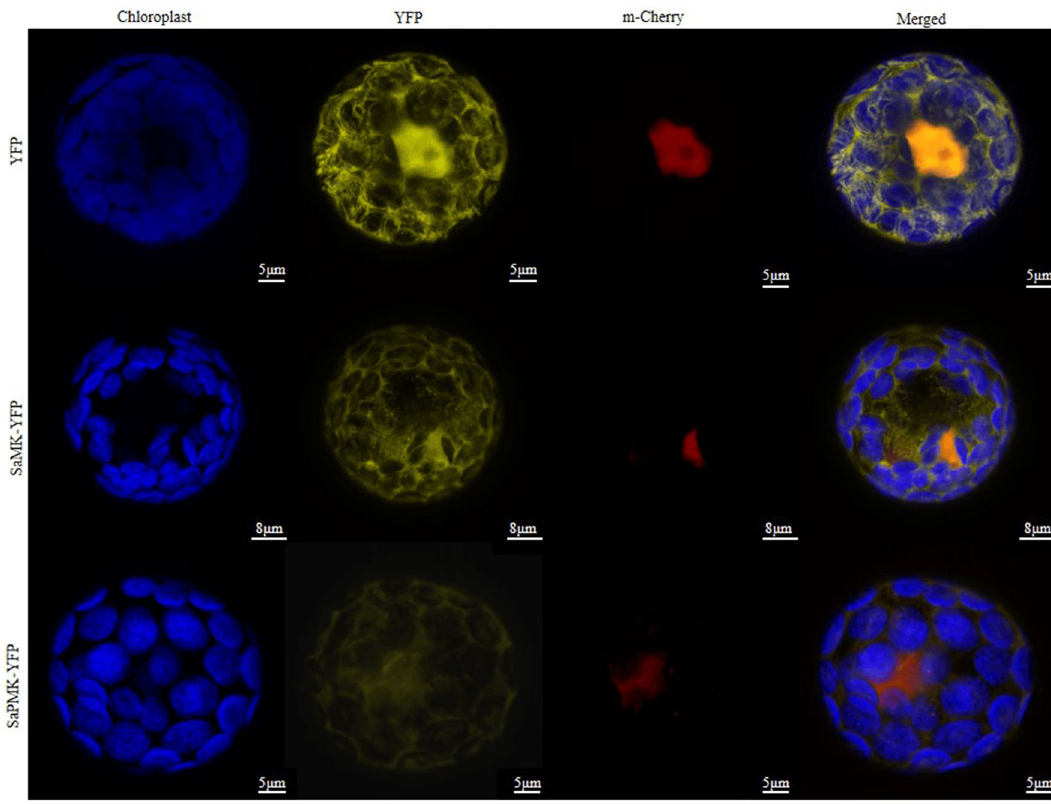
Figure 5. Subcellular localization of Santalum album SaMK and SaPMK. Blue fluorescence indicates chlorophyll (Chl) autofluorescence, yellow fluorescence indicates YFP and fusion vectors signal, and red signal indicates m-Cherry fluorescence. The merged images represent a digital combination of Chl autofluorescence, YFP fluorescent and m-Cherry protein fluorescence. Scale bars: SaPMK-YFP and YFP = 5 μm; SaMK- YFP = 8 μm.